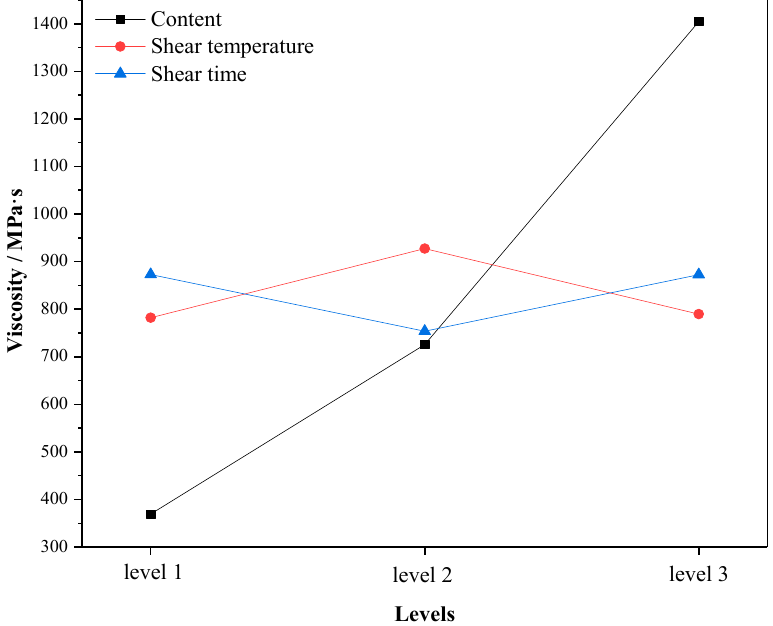
Figure 2. The variation of the mean 175 ◦ C viscosity with the